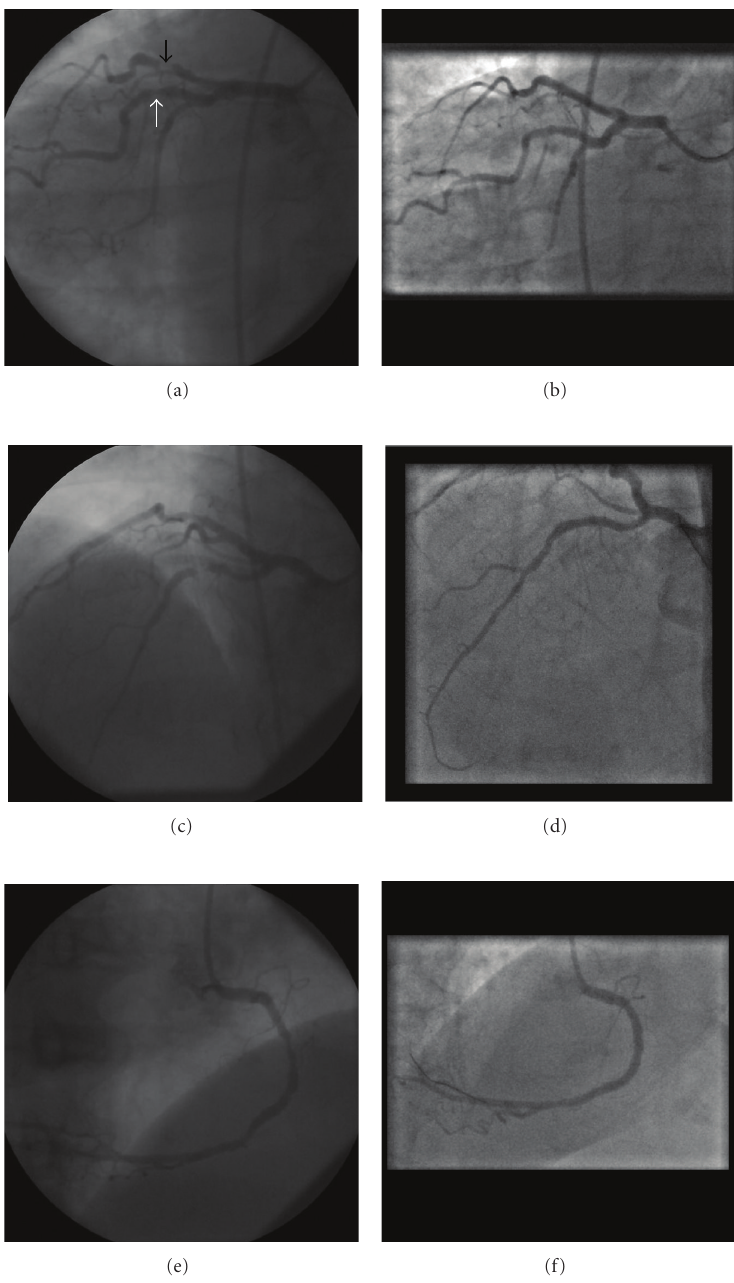
Figure 2: Coronary angiograms pre and post coronary intervention (left and right columns, resp.). Panels (a, b): Left anterior Oblique (LAO) caudal view showing lesion in large obtuse marginal (white arrow) and severe stenosis of LAD (black arrow), Panels (c, d): PA cranial view showing severe LAD stenosis prior to (c) and post intervention (d). Panels (e, f): Left-sided right coronary. artery in Right anterior oblique (RAO)